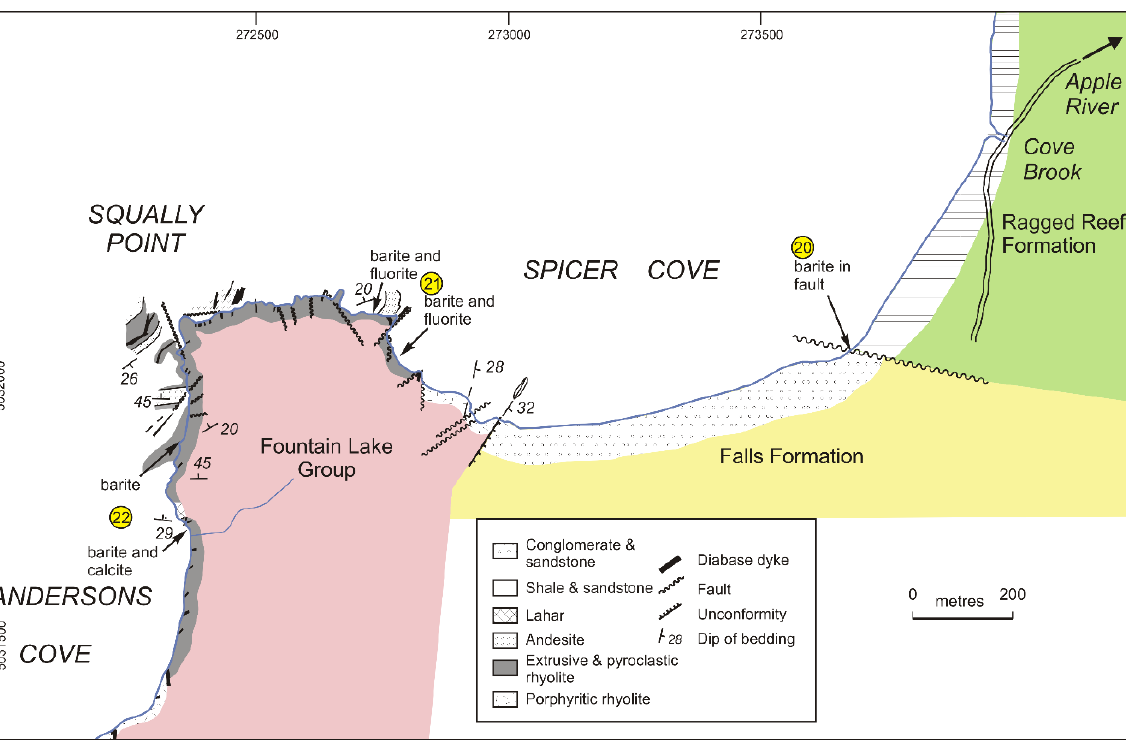
Figure 3. Geological map of the Squally Point area (UTM coordinates), showing location of barite mineralization (numbers refer to Table 1). Base map modified from [10]. Lithologies of coastal outcrops in legend; colours indicate stratigraphic units.